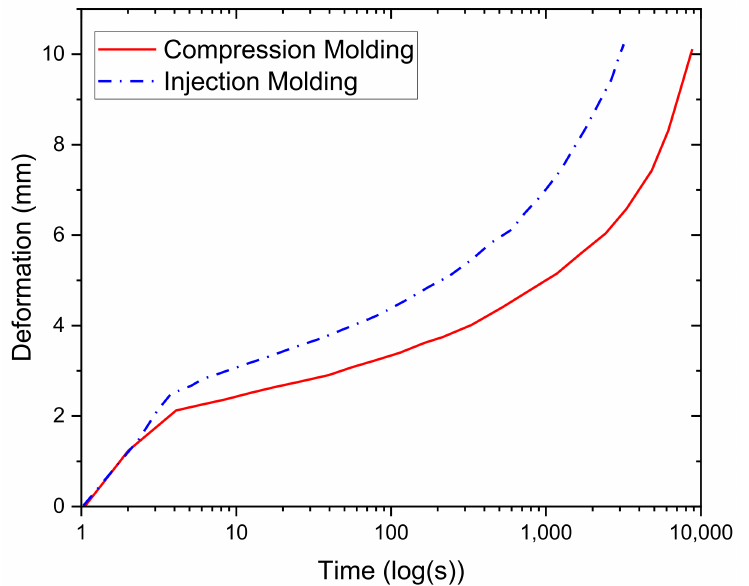
Figure 8. Creep testing for both compression-molded and injection-molded